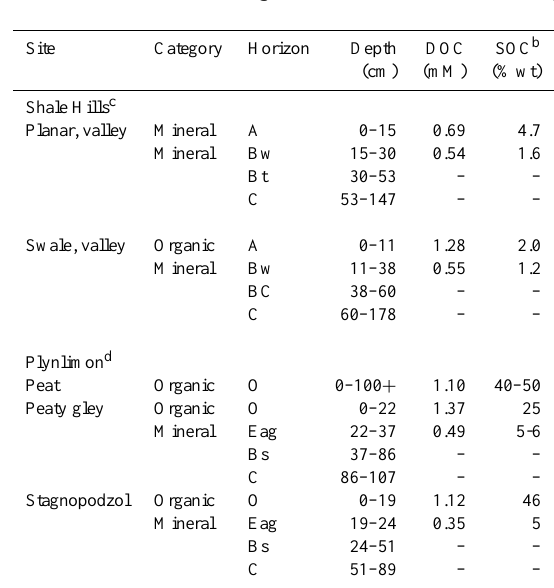
Table 1. Soil profile descriptions and associated soil organic carbon (SOC) (%wt) and dissolved organic carbon (DOC) (mM)